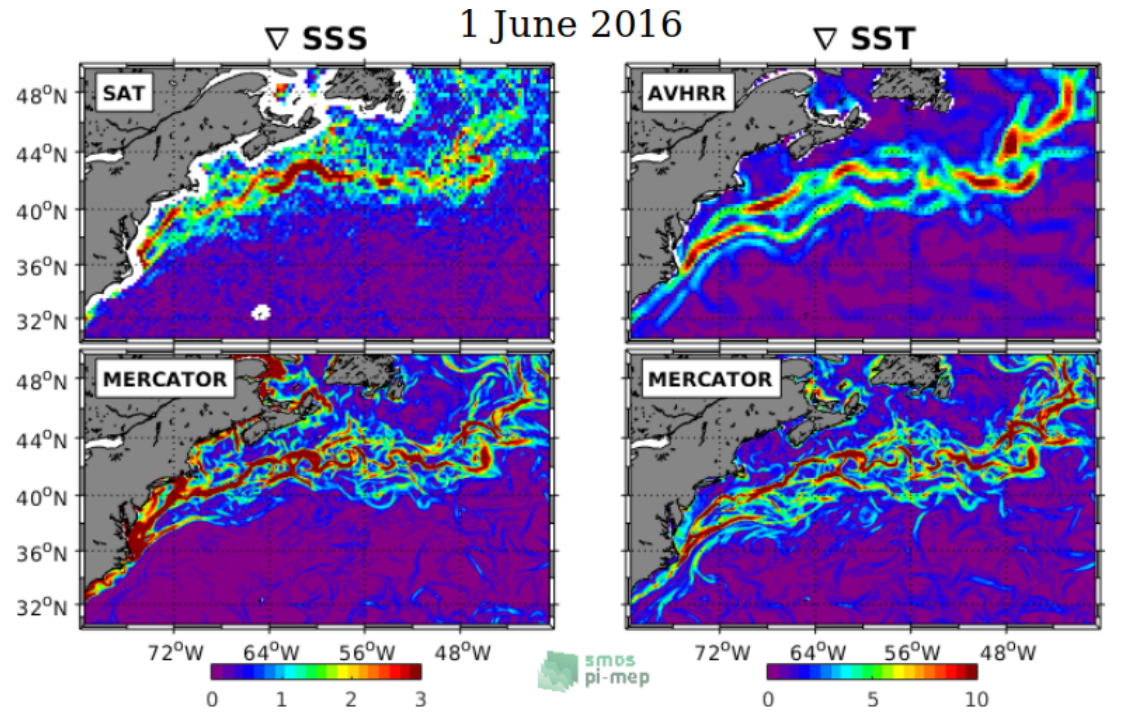
Figure 19. Gradients of monthly averaged SSS ( left ) and SST ( right ) maps from CCI SSS product and AVHRR ( top ), and from Mercator ( bottom ) operational forecast system.